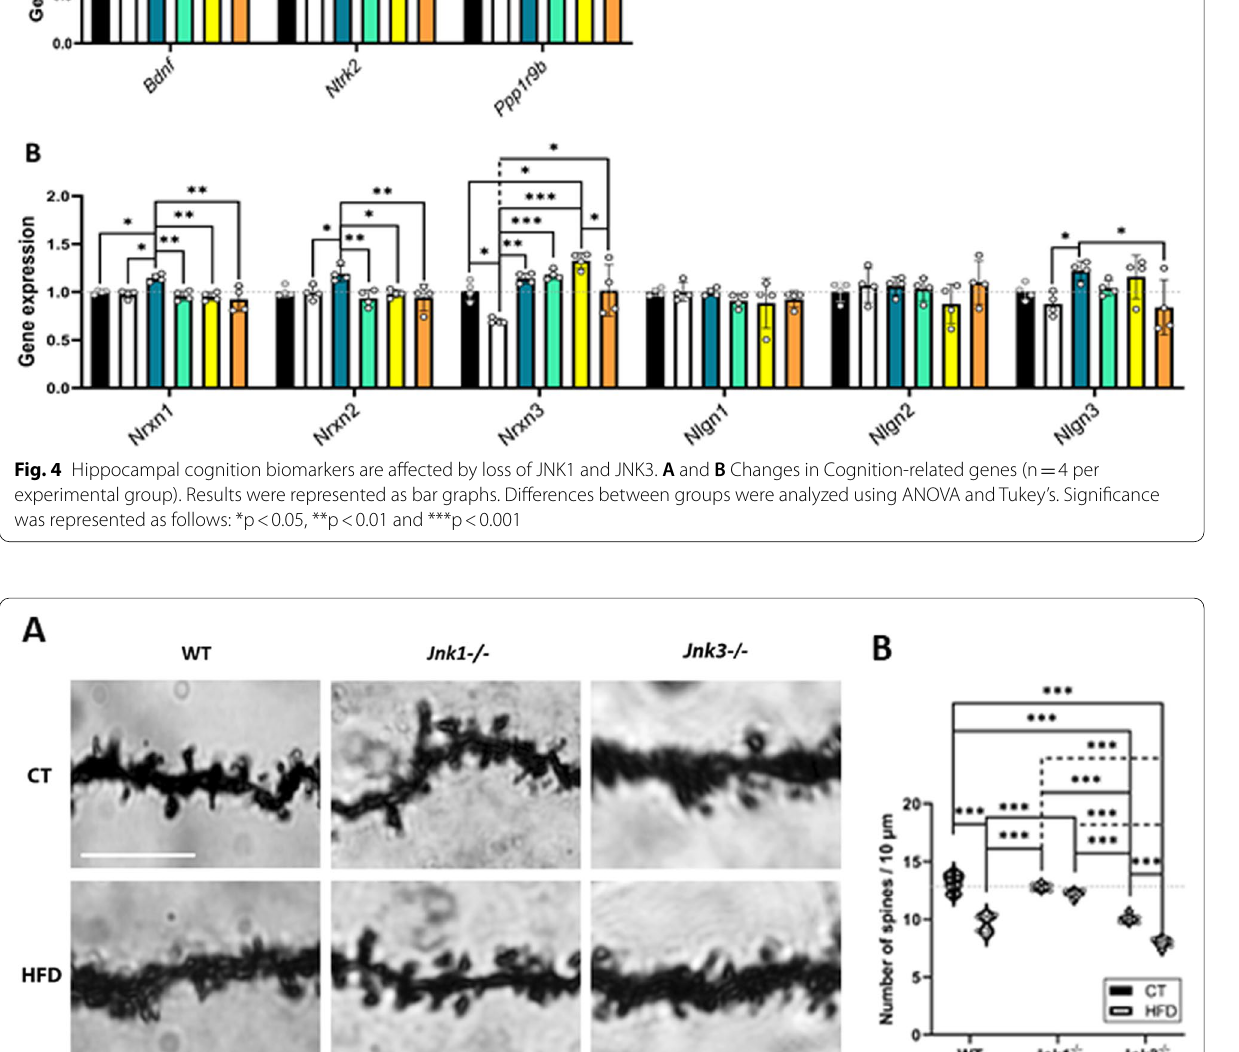
Fig. 5 A Representative image of the state of the dendritic spines as observed in the optical microscope for each experimental group (Golgi stain). Scale bar: 10 µm. B Comparative quantification of the number of dendritic spines in 10 µm sections of the dendritic arborization of neurons of the hippocampal dentate gyrus (n 8/experimental group). Results were represented as violin plots ( B ). Differences between groups were analyzed = using ANOVA and Tukey’s. Significance was represented as follows: *p < 0.05, **p < 0.01 and ***p <